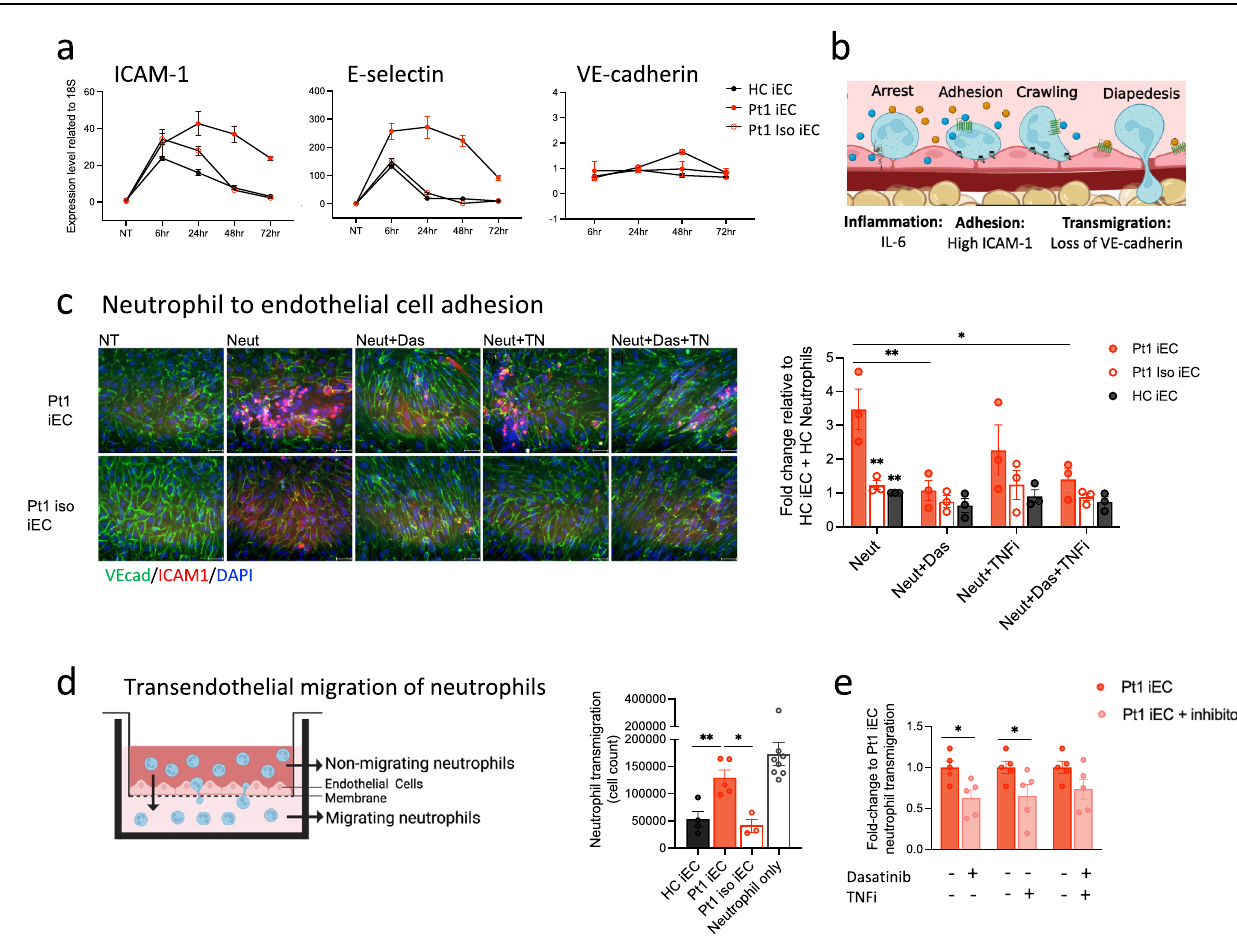
Fig. 5| Co-cultureofneutrophilsand inducedendothelialcells(iECs)increases neutrophil adhesion, and transendothelial migration (TEM). a mRNA expres- sion of the endothelial cell markers ICAM-1, E-selectin, and VE-cadherin (VEcad) in Pt.1 ’ s iECs (Pt1 iECs), a genetically corrected isogenic iEC clone (Pt1 iso iEC) and a healthy controliEC (HC iEC) wasquanti fi ed upon stimulation with IL-1 β (10ng/ml). The datawerecollected from n =3 independently derived iECcelllines for HCand Pt.1. One CRISPR/Cas9 edited Pt1 cell line was generated (iso iEC). Depicted are all biological and technical replicates for HC and Pt1 iEC, and technical replicates for Pt1isoiEC.Dataarepresentedasmeanvalues±SEM. b Schematicrepresentationof neutrophil extravasation shows critical steps preceding diapedesis. Created with BioRender.com . c Co-culturesofHCneutrophils(Neut)withPt.1iECs(upperpanels) orisoIECs(lowerpanels)for48hshowneutrophiladhesioninmutantcomparedto iso iEC ( p =0.0058) and HC iEC ( p =0.0019) co-cultures, with the effect of treat- ment with dasatinib (Das, p =0.0027), a TNF inhibitor (TNFi, p =0.4089) or both (Das+TNFi, p =0.0135) on neutrophil adhesion. Images are representative of 3